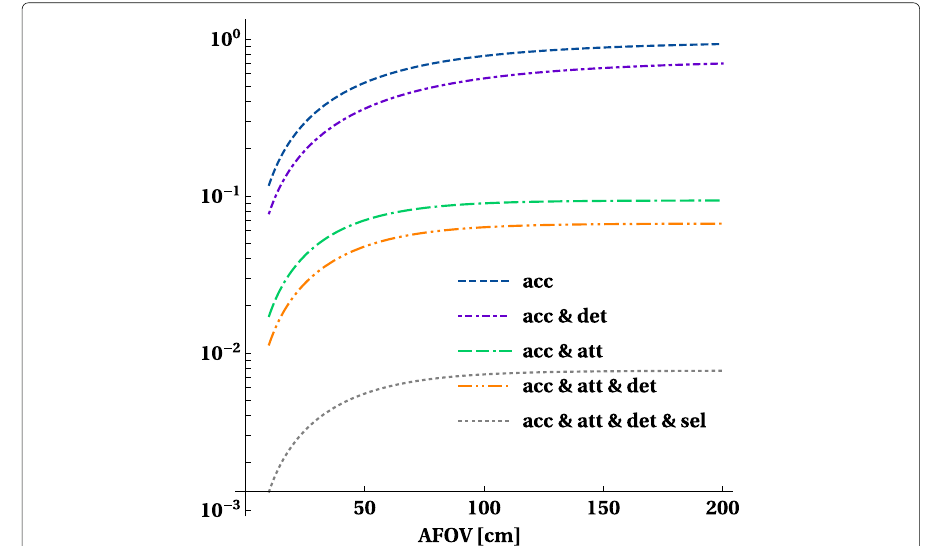
Fig. 5 The fraction of detected two-photon events for a central point source taking into account the detector acceptance (Acc), detection with 20-mm-thick LYSO crystals (Acc & Det), attenuation caused by a 20-cm phantom (Acc & Att) as well as (Acc & Att & Det) and selection of event forming events (Acc & Att & Det & Sel). The y -axis displays fraction with maximum value equal to